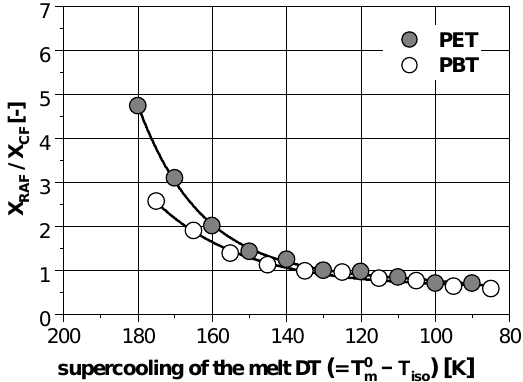
Figure 5. Specific rigid amorphous fraction ( X RAF / X CF ) in dependence on the isothermal super- cooling of the melt for PET and PBT, derived from the data in Figure 4. The lines are for visual purposes